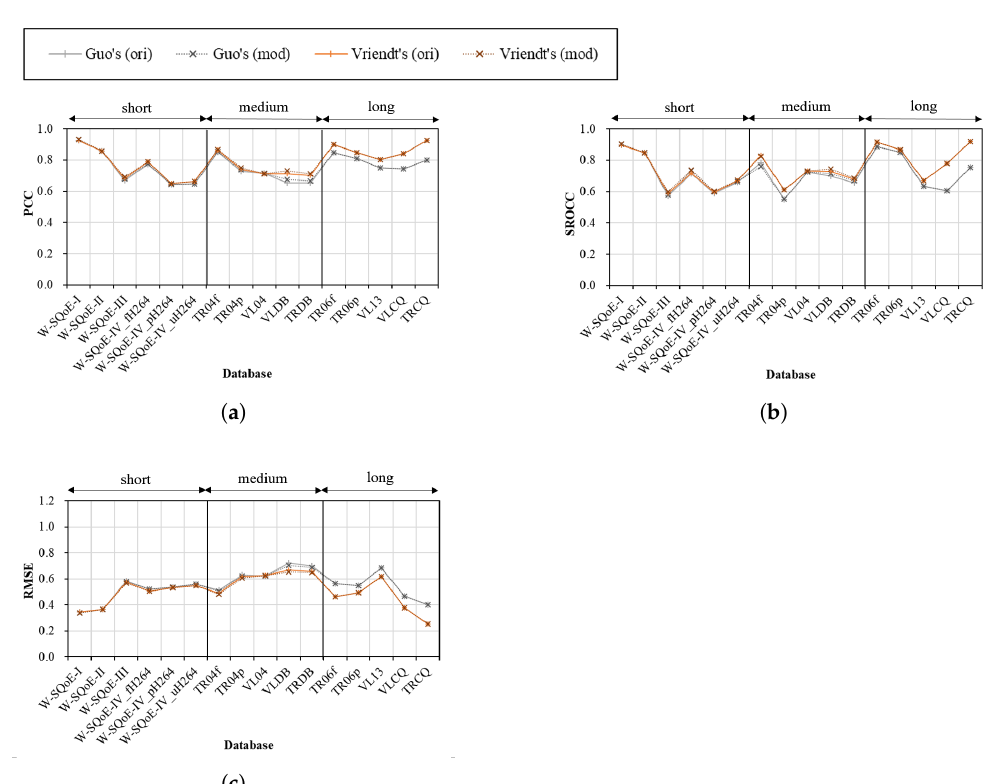
Figure 8. Performance of Guo’s and Vriendt’s models in the third group over the test databases. ( a ) PCC; ( b ) SROCC; ( c )